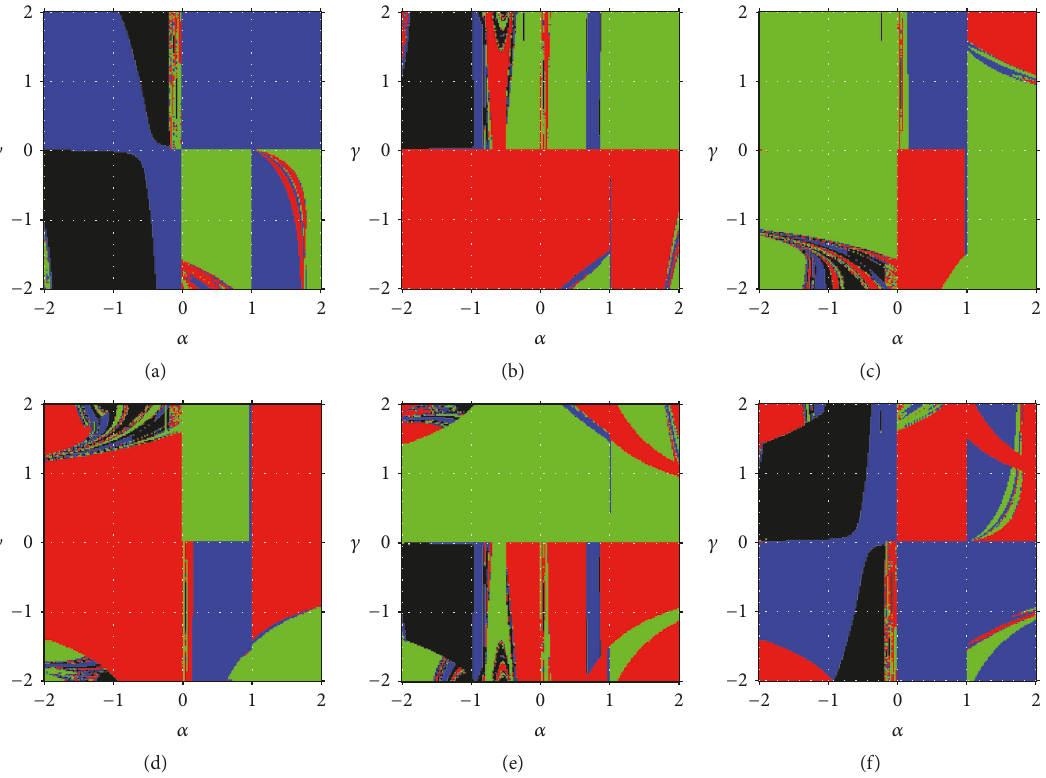
Figure 2: Parameter planes of (a) 𝑥 𝐶 5 , (b) 𝑥 𝐶 6 , (c) 𝑥 𝐶 7 , (d) 𝑥 𝐶 8 , (e) 𝑥 𝐶 9 , and (f) 𝑥 𝐶 10 (red: 𝑥 ∗ 1 , green: 𝑥 ∗ 2 , blue: 𝑥 ∗ ∞ , and black: others).